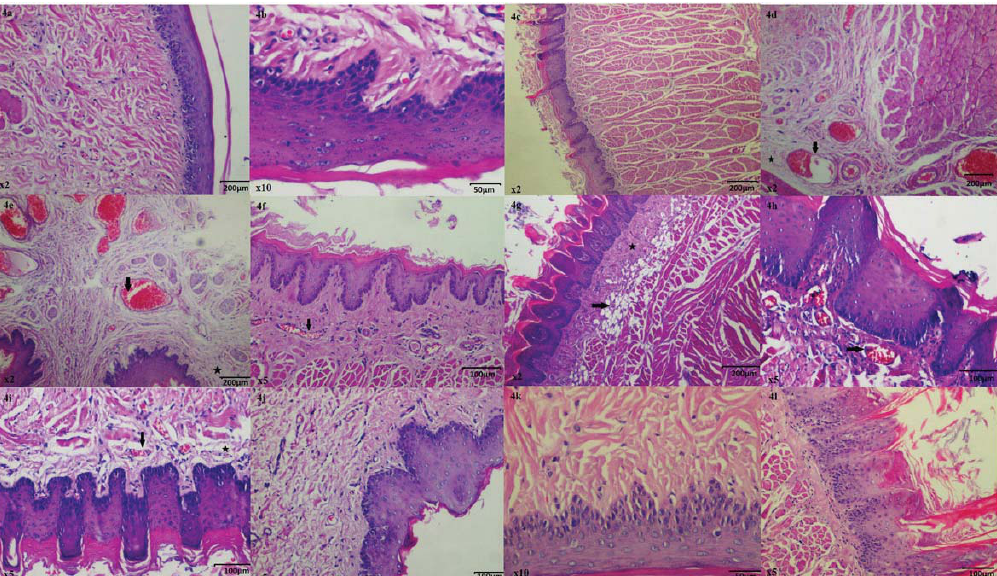
Figure 4- a: Normal histopathologic appearance of the rat cheek tissue of Healthy Group (HG) (HE&40); b: Normal histopathologic appearance of the rat cheek tissue of HG (HE&20); c: Normal histopathologic appearance of the rat cheek tissue of HG (HE&40); d: Dilated congested blood vessels (arrow) and edema (star) are distinguished in the cheek mucosa of MTXC group given methotrexate (MTX) (HEx40); e: Mild edema (star) and dilated congested blood vessels (arrow) are monitored in the lip mucosa of MTXC group given MTX (HEx40); f: Dilated congested blood vessels are seen in the